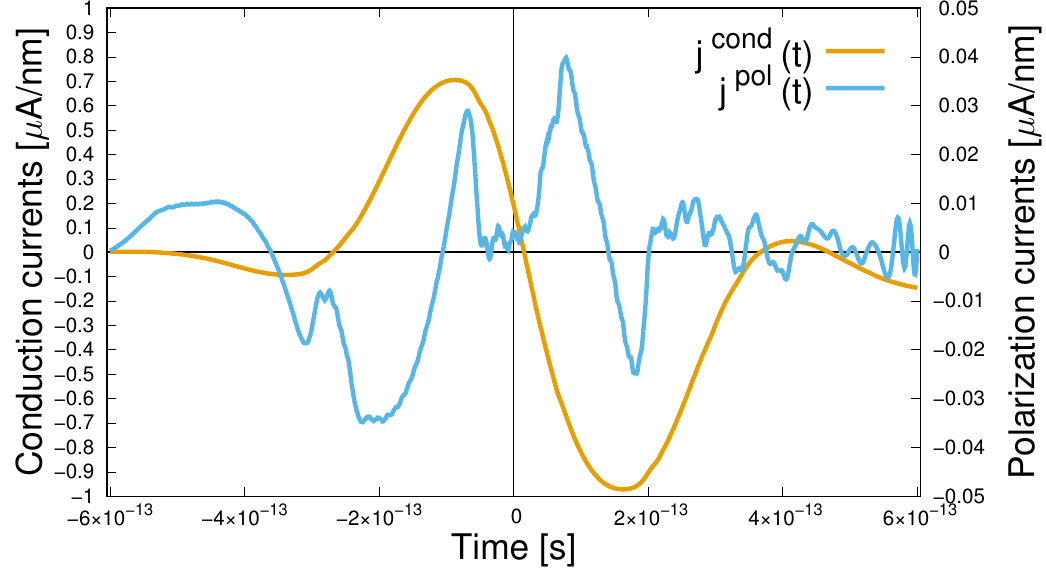
Figure 11. Time dependence of the conduction and polarization currents for a pulsed alternating field with a cyclic frequency ω = 2 π 2 ×